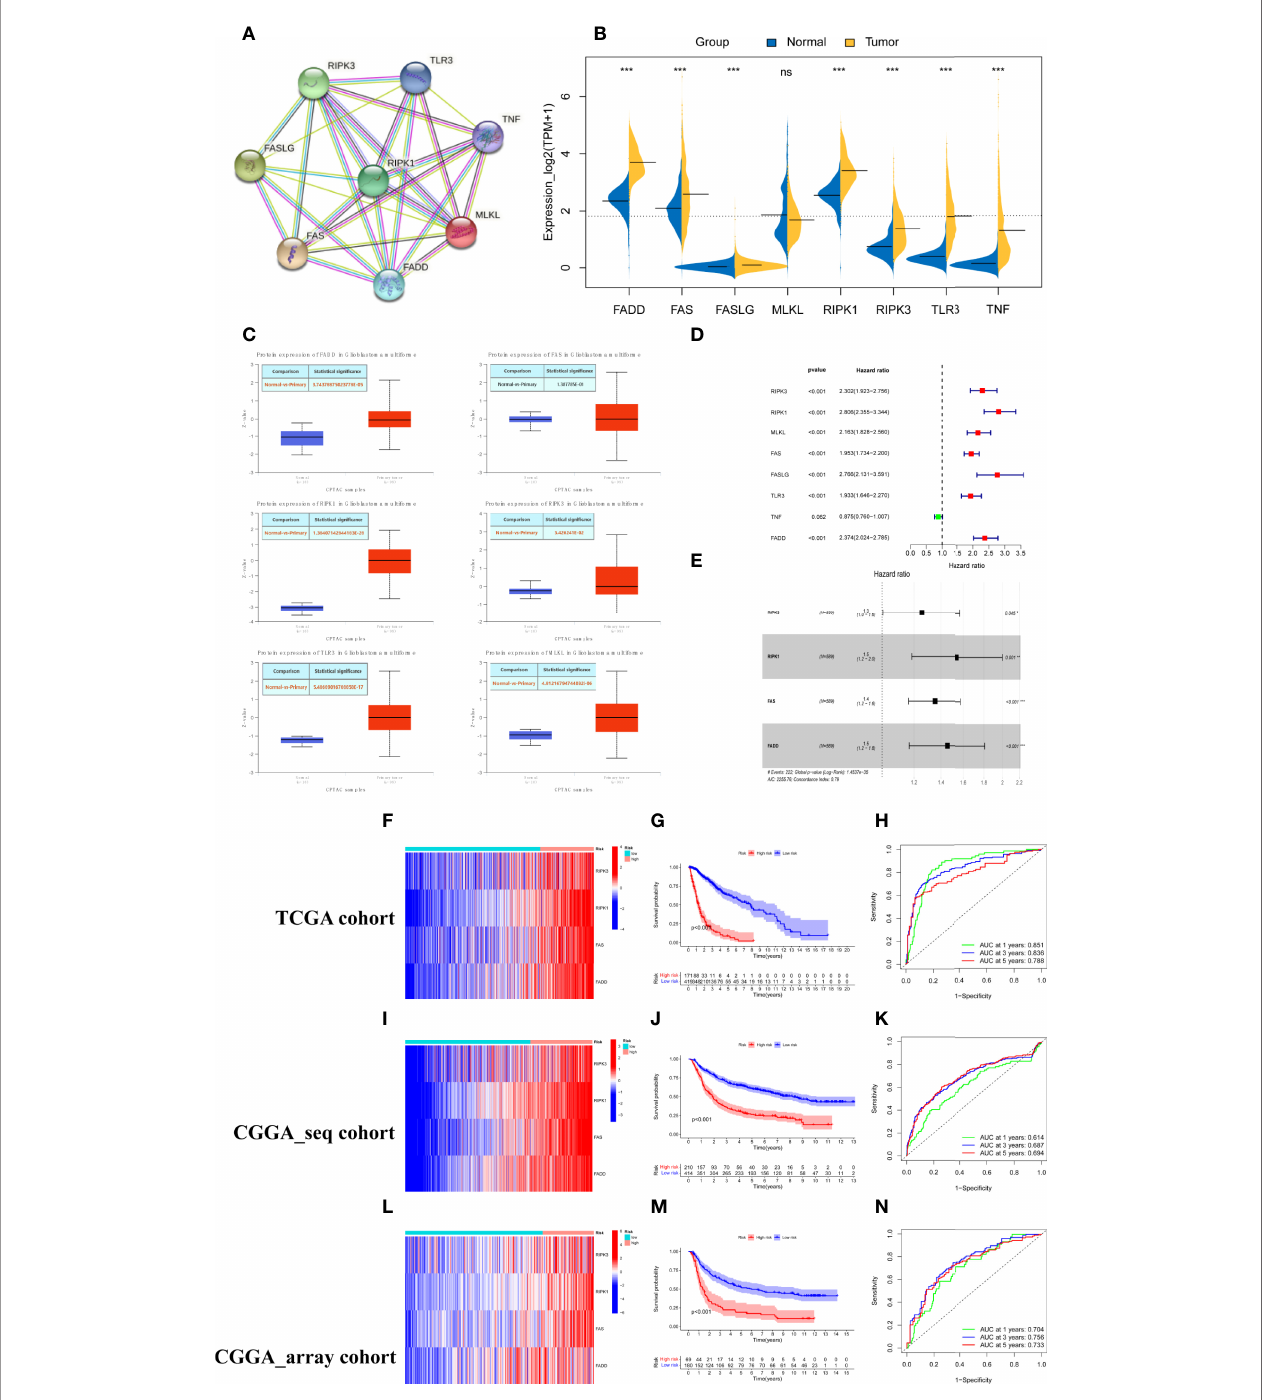
FIGURE 1 | Construction and validation of the necroptosis gene signature. (A) PPI network of necroptosis genes. (B) The expression levels of 8 necroptosis genes in the primary gliomas and normal cerebral cortex tissues (* represented p < 0.05, * represented p < 0.01**,* represented p < 0.001 and ns was no statistical signi fi cance). (C) The protein expression levels of necroptosis genes in glioblastoma and normal brain tissues from the UALCAN database. (D) Screened 7 prognostic necroptosis genes by univariate cox regression analysis with a criterion of p < 0.05. (E) Identi fi ed 4 genes to construct the risk model using multivariate cox analysis. (F, I, L) Heatmap of the expression of risk genes in the training and two test cohorts. (G, J, M) Kaplan – Meier survival curves for comparison of survival rates between different risk populations in the TCGA cohort and validated using CGGA cohorts. (H, K, N) ROC curves of the risk signature for predicting prognosis at 1, 3, and 5 years in the training and two test